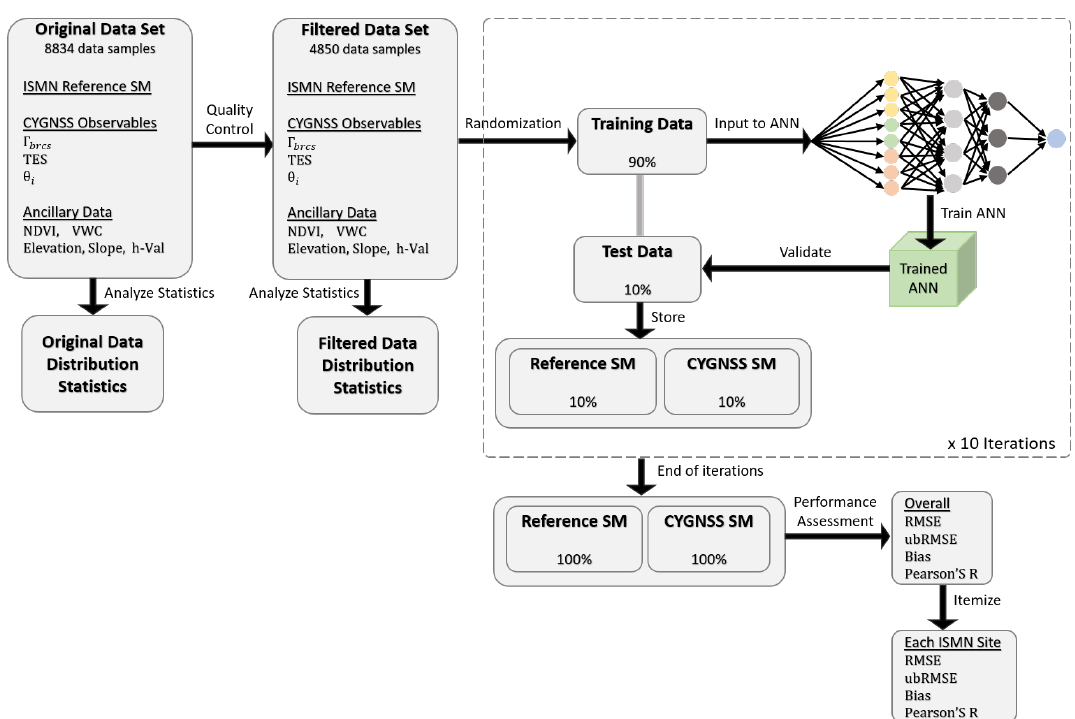
Figure 7. Flowchart showing the training and validation of the CYGNSS SM retrieval